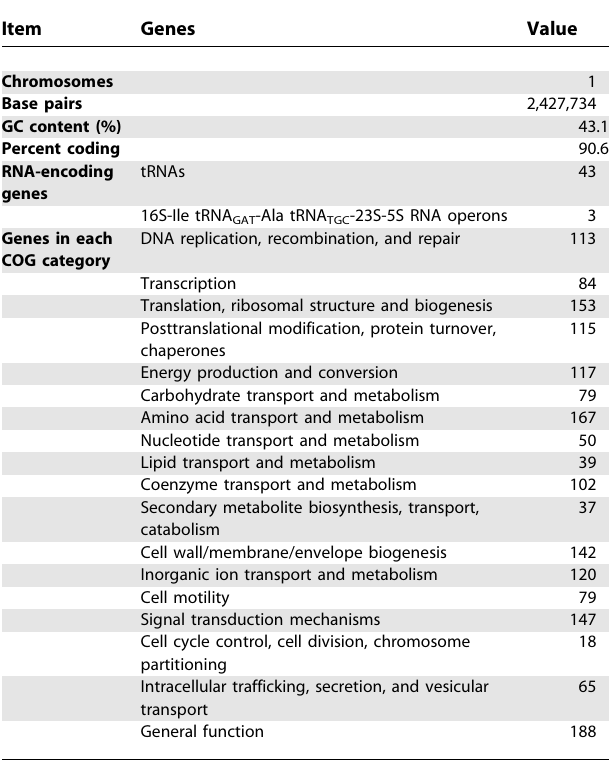
Table 1. Thiom. crunogena XCL-2 Genome Summary